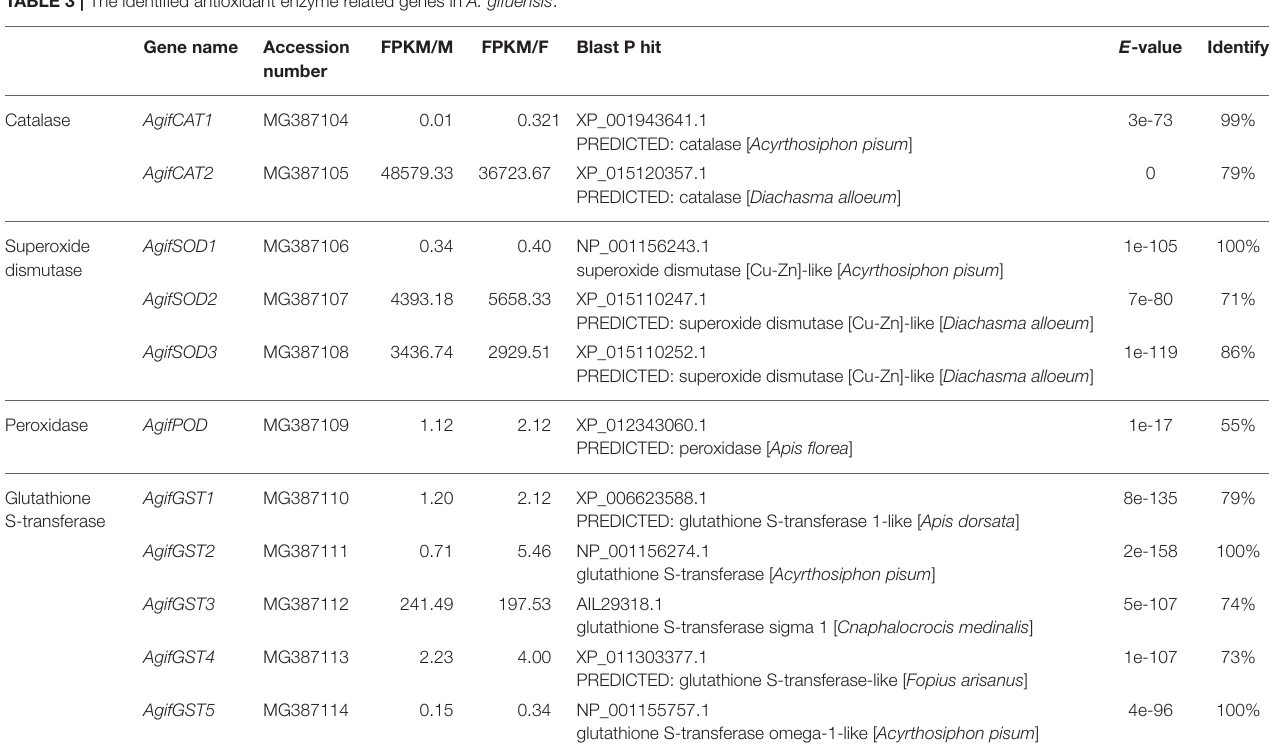
TABLE 3 | The identified antioxidant enzyme related genes in A. gifuensis